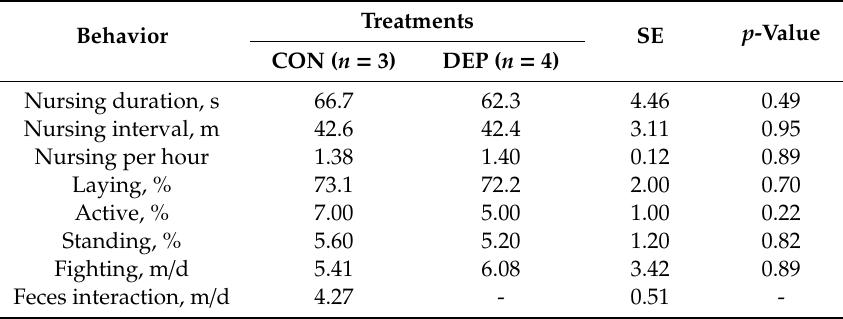
Table 4. Control (CON) and deprived (DEP) litter behaviors at 7 d of